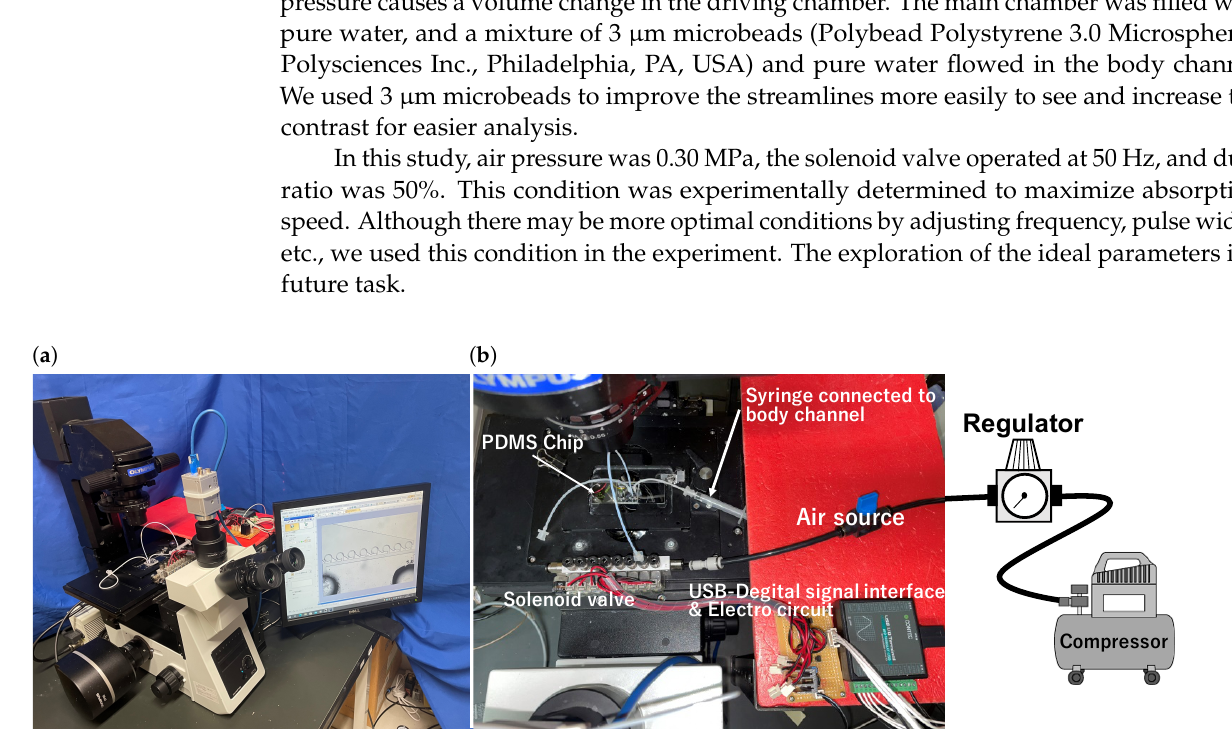
Figure 4. ( a ) Experimental setup. ( b ) Experimental apparatus.